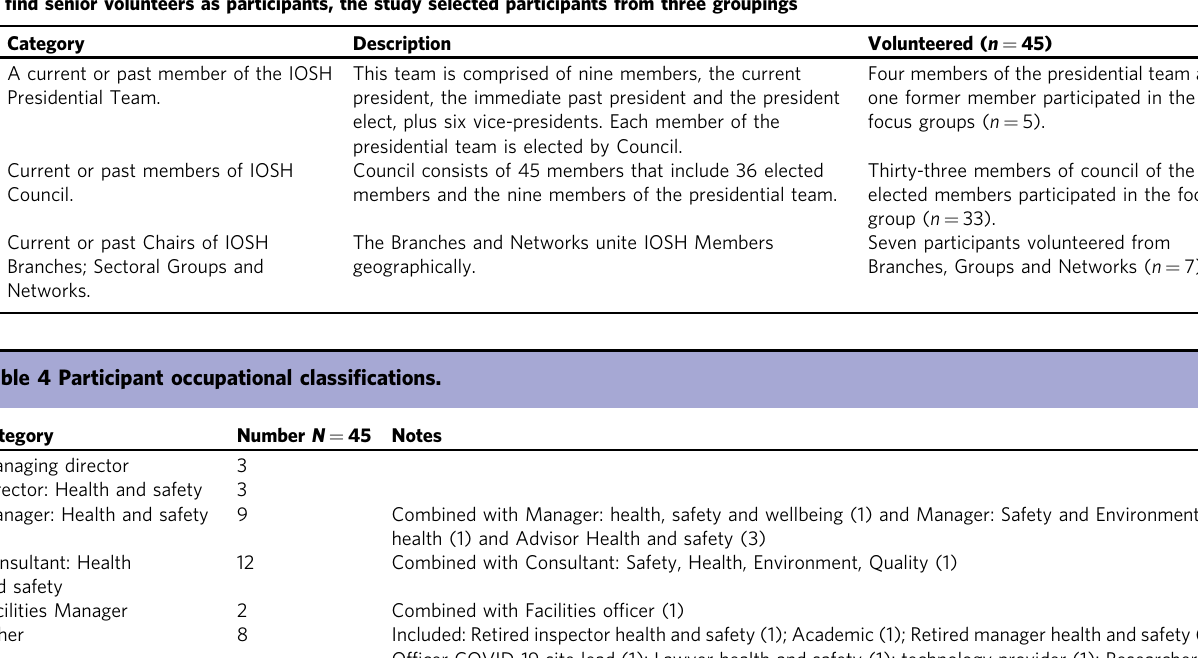
Table 3 Volunteer participant groups.